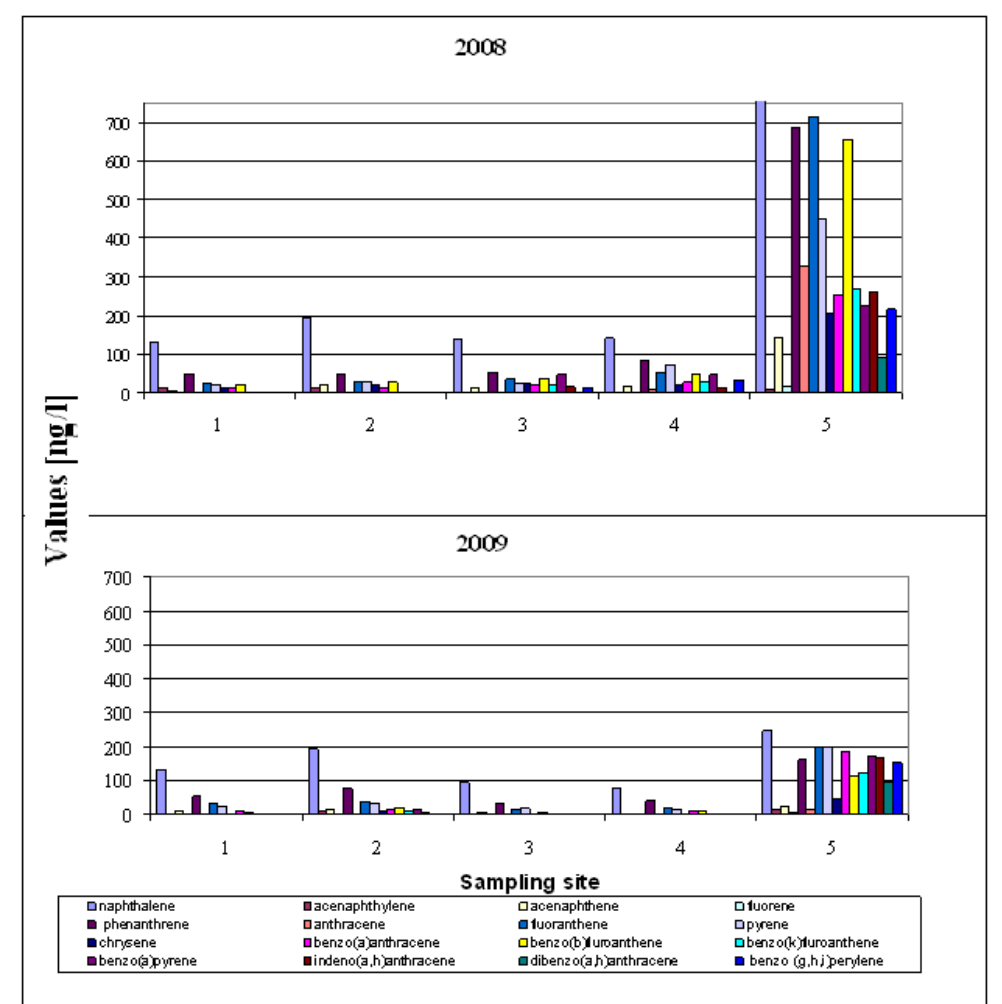
Figure 3 . Concentration of PAHs determined in runoff water taken from five sampling locations at Gda ń sk Airport